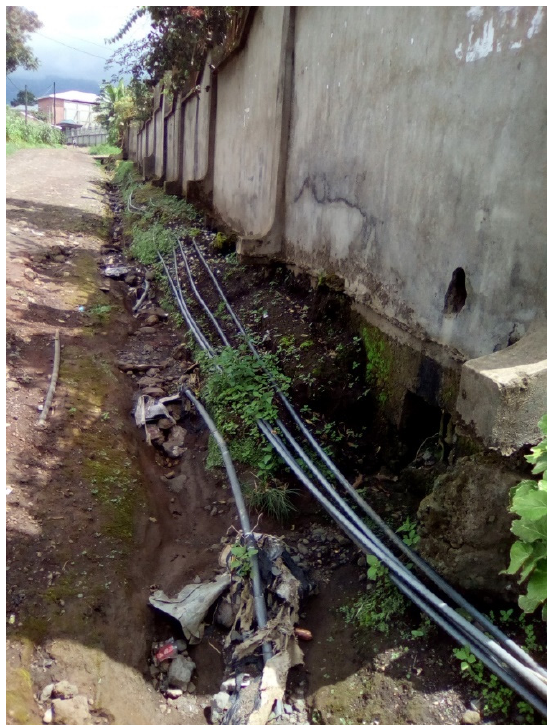
Figure 1. An example of WDN transporting water to a user’s premise.